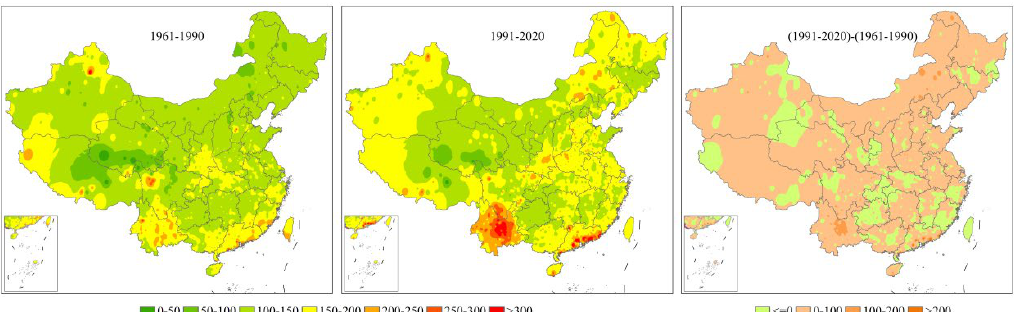
Figure 9. Variation in insolation during the potential agricultural growing season for the indicated time periods.